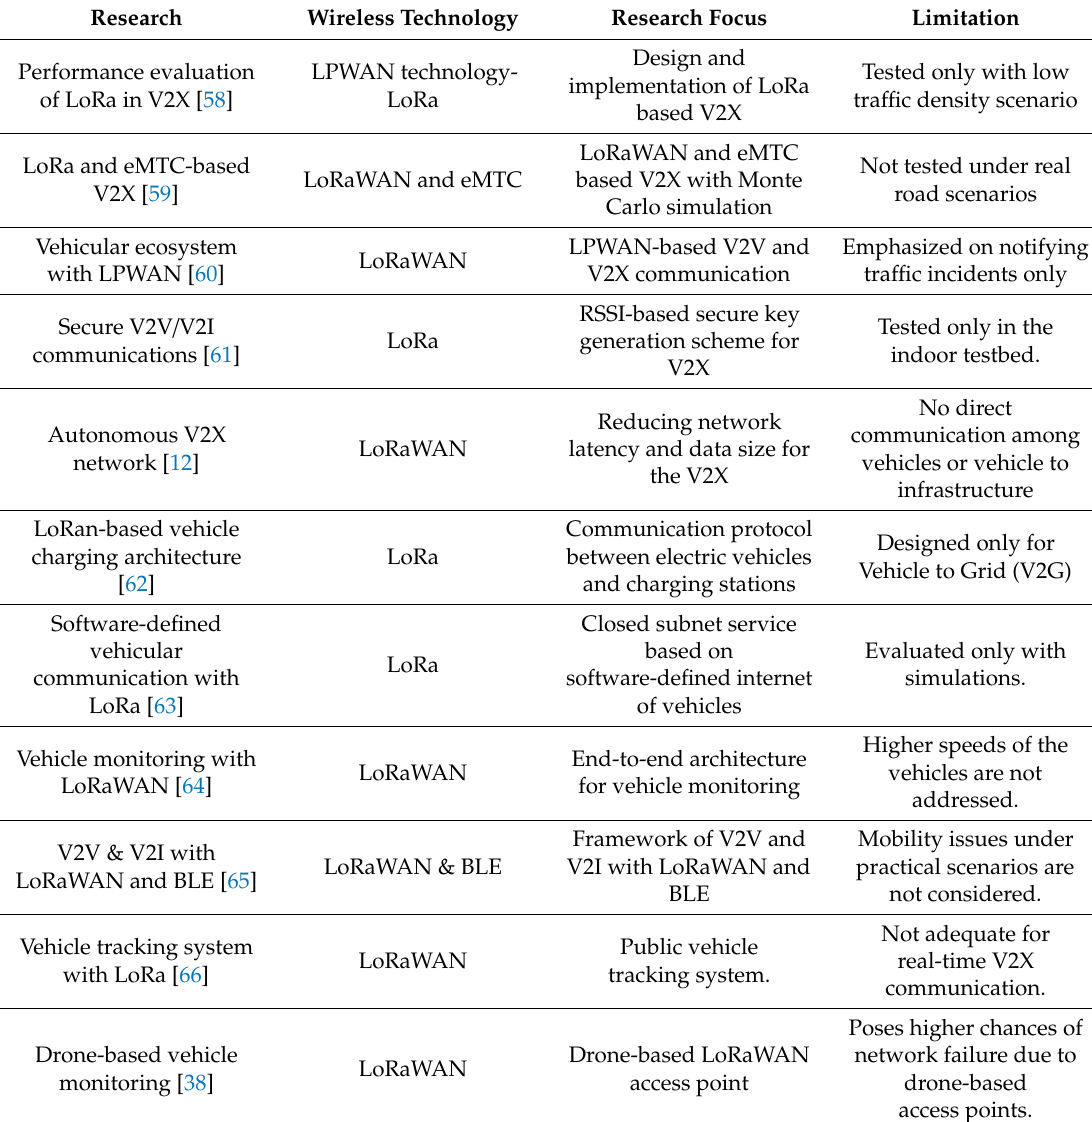
Table 2. Research focus, wireless technologies, and limitations of different LoRa-based vehicular